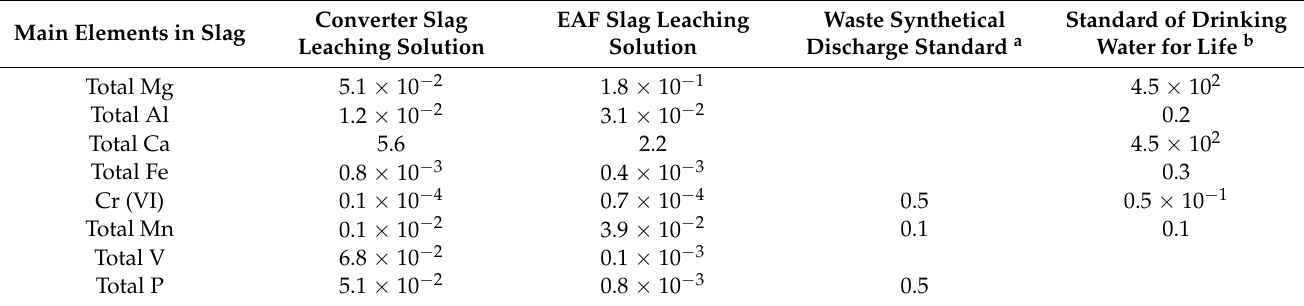
Table 6. Concentrations of main elements in converter slag and EAF slag leaching solutions, (mg/L). Main Elements in